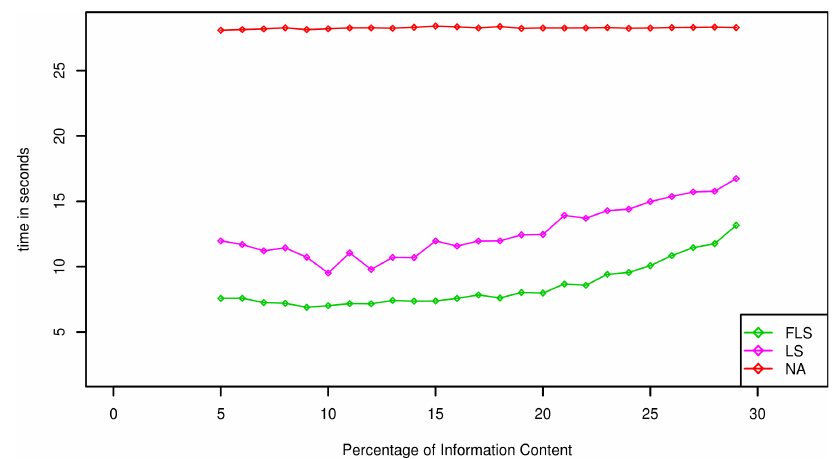
Fig 2. Average running times (in Seconds, Preprocessing excluded) of different algorithms for model MOD1 with p-value γ = 0.0001.